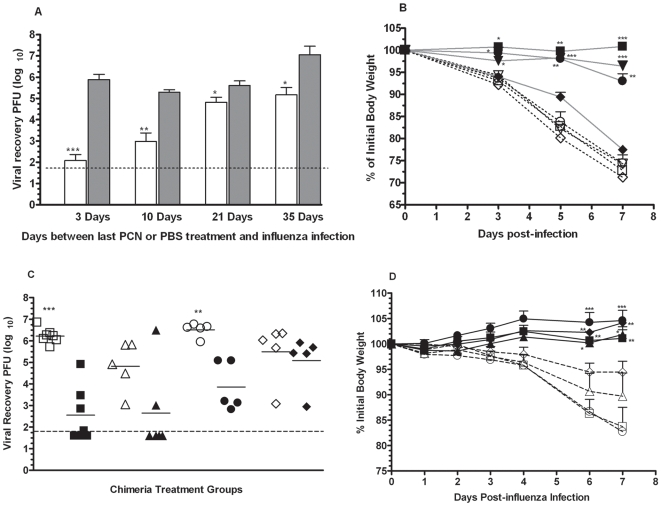
Effect of PCN treatment endures and elicits iBALT structures that can exclusively resolve PR8 influenza infections.A). Mice that had been treated with PCN (clear bars) or PBS (shaded bars) were rested for a designated period of time before being challenged with influenza virus. Assessment of viral clearance was carried out by plaque assay; *, P<0.05; **, P<0.001; ***, P<0.0001; dotted line is limit of assay detection. B). Weight changes in PCN-treated mice (closed symbols) and the PBS-treated control mice (open symbols) were monitored during the week following influenza virus challenge. Influenza virus challenge was given at 3 days (square symbols), 10 days (triangle symbols), 21 days (circle symbols) and 35 days (diamond symbols) after the conclusion of the PCN treatment regimen; *, P<0.05; **, P<0.005; ***, P<0.0005 relative to corresponding PBS-treated control. C). Splenectomized-irradiated mice were reconstituted with BMC in order to make chimeric mice in which responding iBALT structures could be isolated from all other conventional secondary lymphoid tissues. Wild type chimeric mice – wild type mice that received wild type BMC (square symbols), WT/LTα chimeric mice – wild type mice that received LTα KO BMC (triangle symbols), SLP chimeric mice - LTα KO mice that received wild type BMC (circle symbols) and LTα KO chimeric mice - LTα KO mice that received LTα KO BMC (diamond symbols). Following engraftment of the transferred BMC, groups of chimeric mice were treated 5x with PCN (solid symbols) or with PBS (open symbols) and then challenged with influenza virus. Viral burdens were determined 7 days after infection. **, P = 0.001; ***, P<0.0001; dotted line is limit of assay detection. D). Changes in body weight relative to that at the time of viral challenge were monitored daily in the PCN and PBS-treated chimeric mice; symbol designations as for Figure 8C; *, P<0.05; **, P<0.005; ***, P<0.0001 relative to corresponding PBS control.